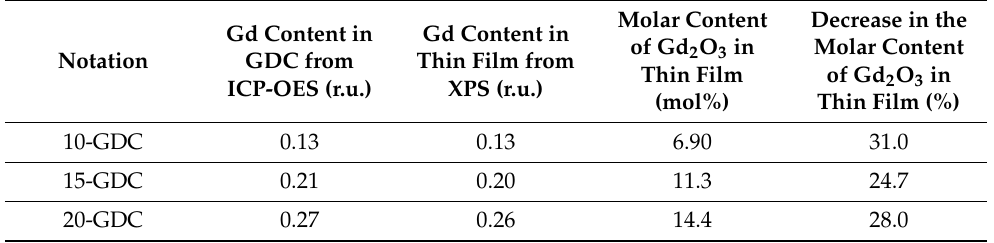
Table 3. The chemical composition of evaporated 10-, 15-, and 20-GDC thin films, obtained from XPS and ICP-OES